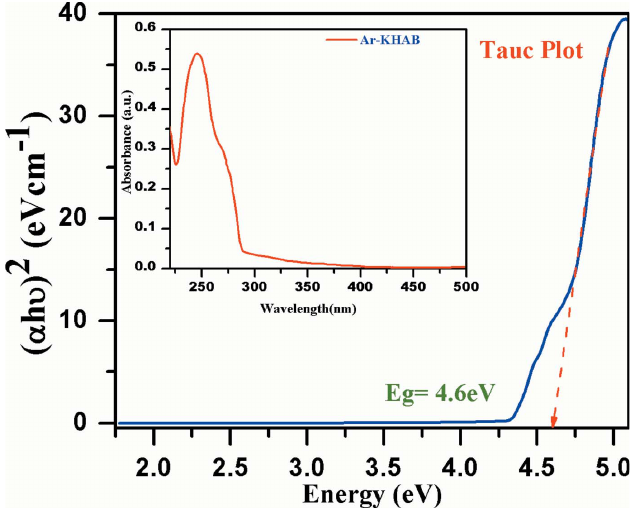
Figure 5 Energy band gap of the title molecule by Tauc plot from absorption